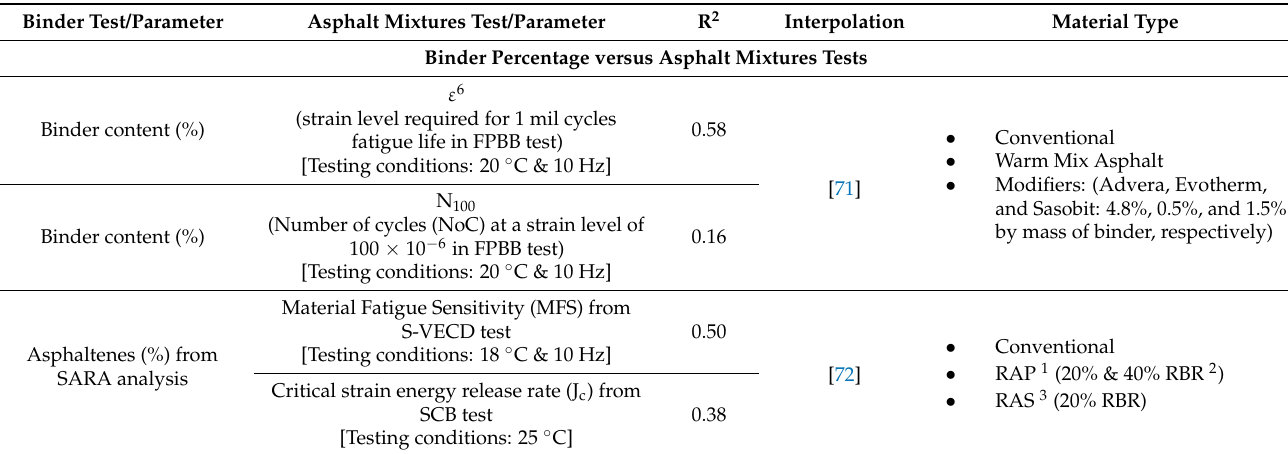
Table 1. Correlations between the properties of bitumen from conventional tests and cracking properties of asphalt mixtures from various tests.